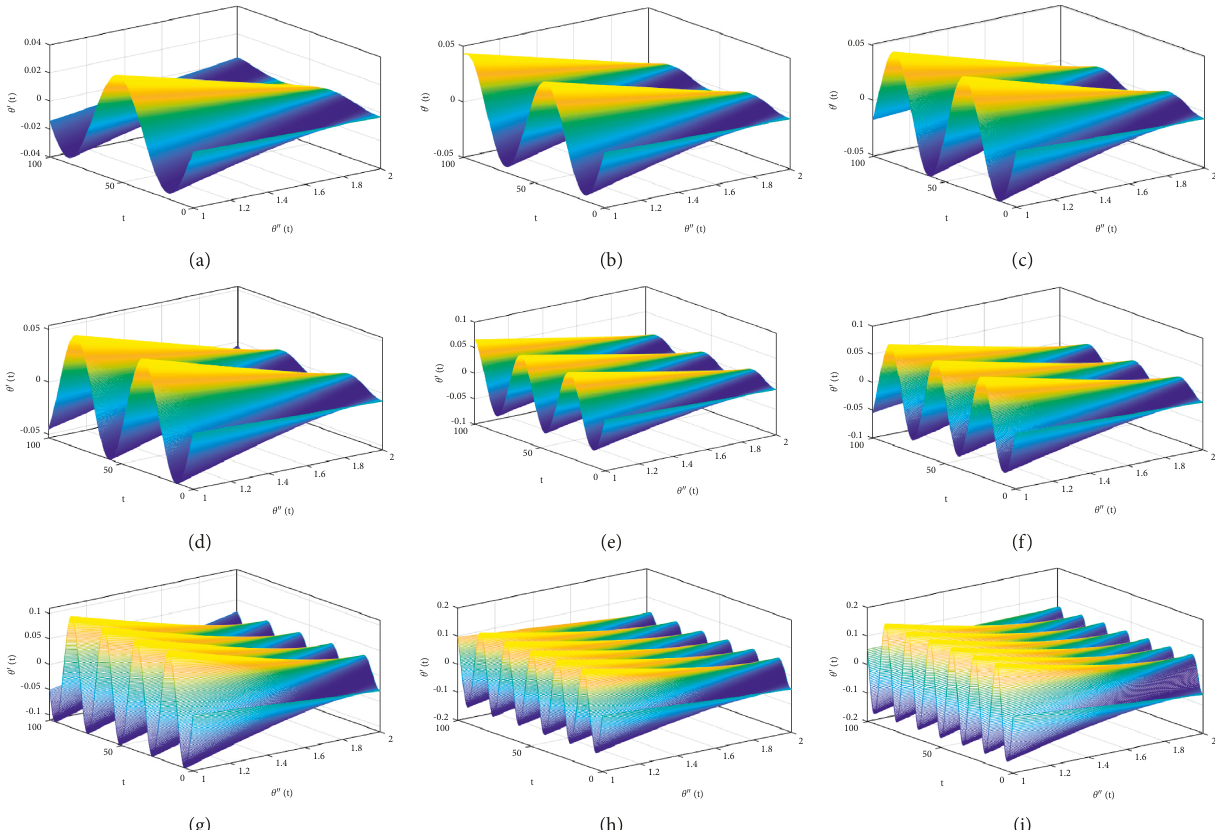
Figure 6: Surface plots for the comparison of angular velocity and acceleration of different cases and scenarios of oscillation in the homogenous circular